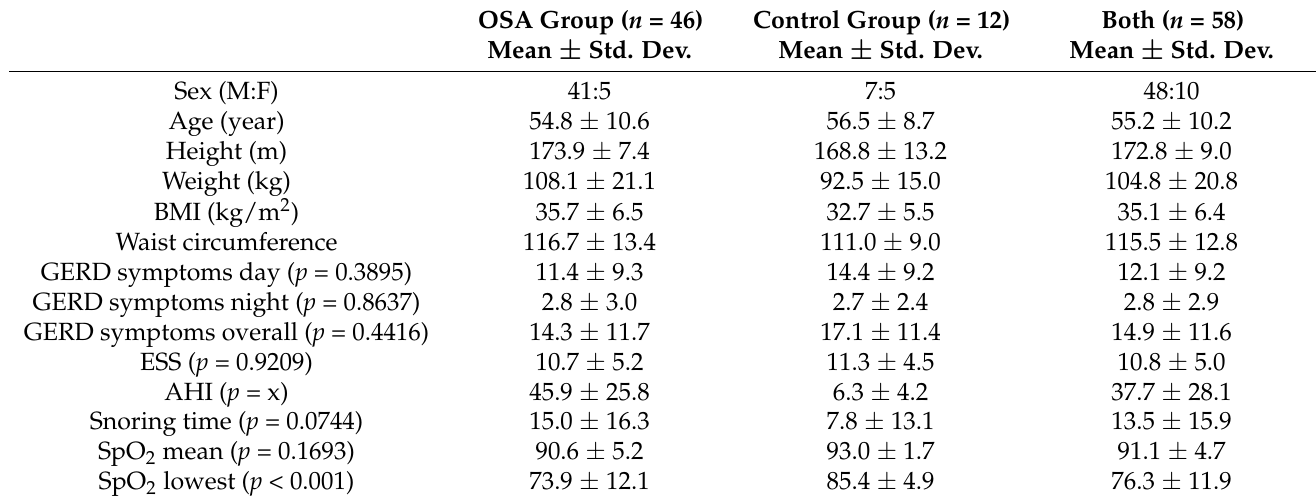
Table 1. Basic characteristics of the study population, severity of GERD symptoms, and polysomnographic parameters’ distribution and comparison of variables between the test and control groups.